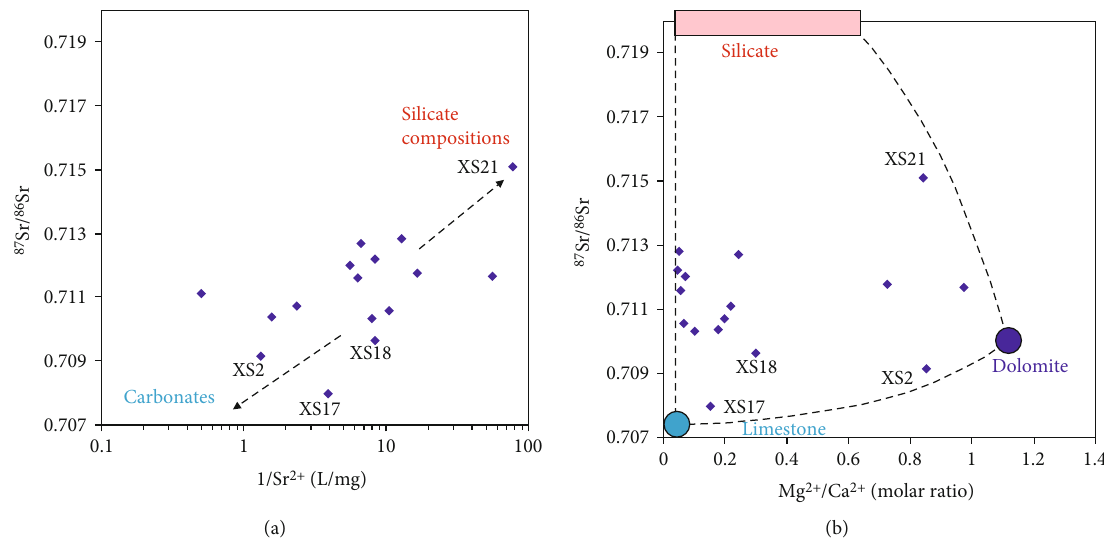
Figure 5: Relationship between 87 Sr/ 86 Sr and 1/Sr 2+ (a) and between 87 Sr/ 86 Sr and Mg 2+ /Ca 2+ (b). The three end-members of limestone, dolomite, and silicate are modi fi ed from [54].